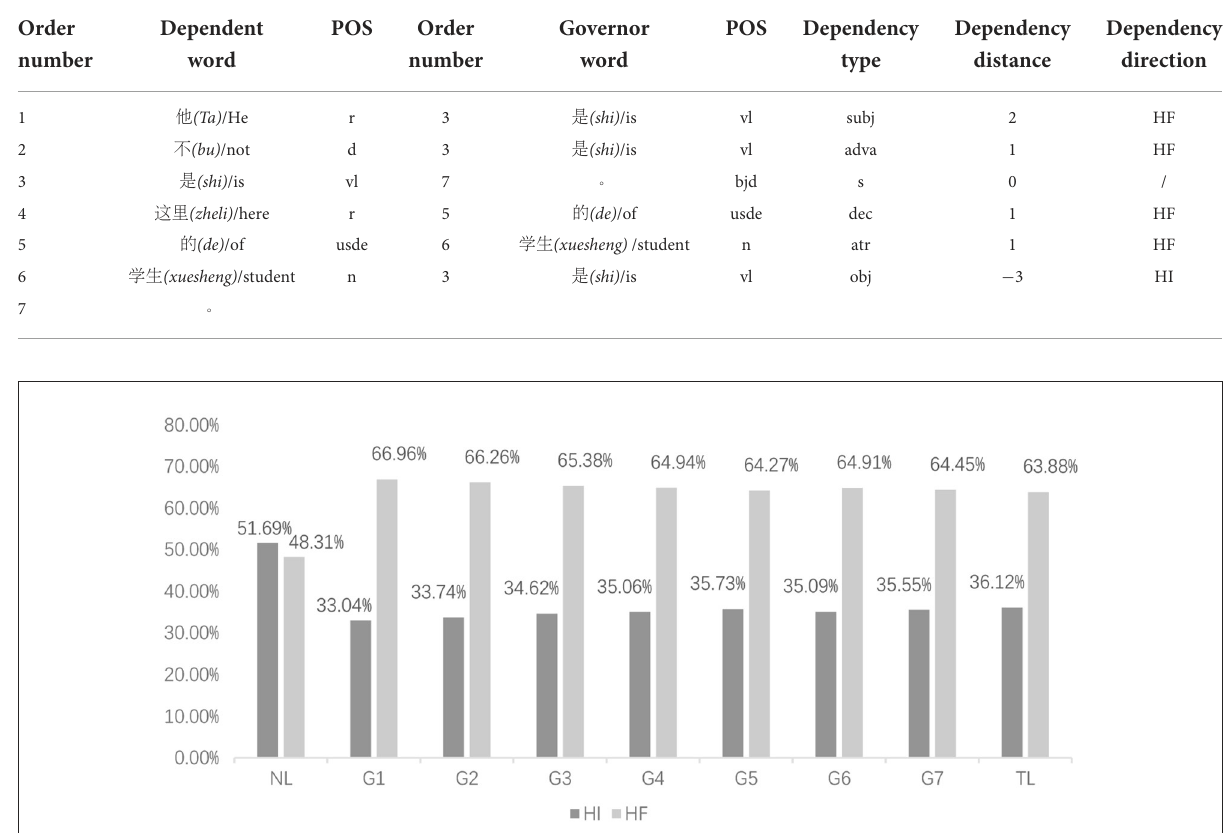
FIGURE2 In written modality, distribution of ECSL learners’ dependency directions at each level and in the contrastive treebanks. NL, native language; TL, target